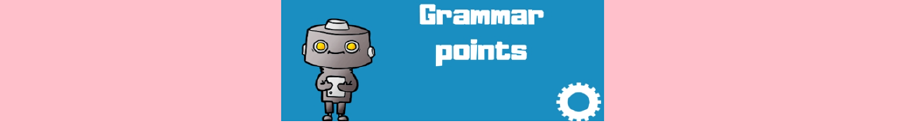
Figure 11. Automatic judgment of wrong answer rate. The source of the computer simulation algorithm for automatic judgment of learning by level completed in this paper is shown in Algorithms 1 as follows: